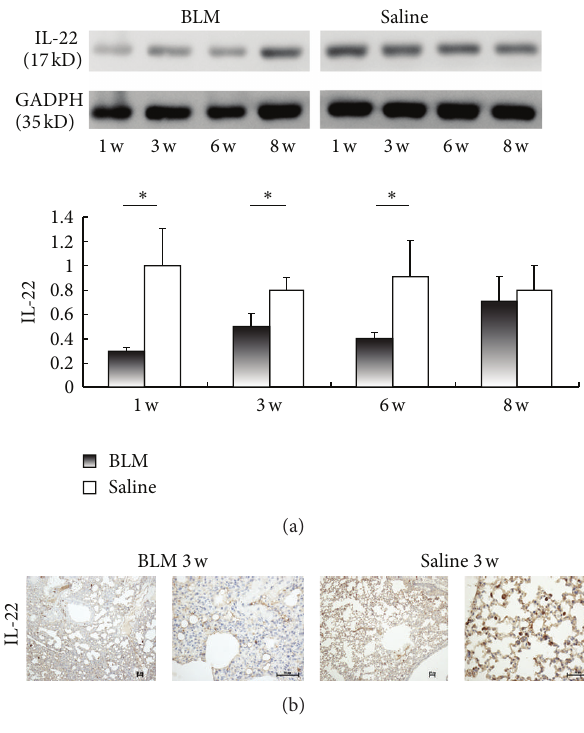
Figure 2: IL-22 is downregulated in lungs from bleomycin-treated mice. (a) Total protein level of IL-22 in lung homogenates was determined by western blotting and analyzed by densitometry compared to GADPH expression. The same amounts of total protein are loaded in each lane. Experiments were performed twice with similar results, with the same amounts of total protein loaded in each lane. (b) Representative photomicrographs of lung sections were obtained from mice treated with BLM or saline (week 3). IL- 22-positive cells were examined by immunohistochemistry. Bars = 50 𝜇 m. ∗ = 𝑃 < 0.05 ; ∗∗ = 𝑃 < 0.01 . Data presented in (a) are representative of results from two independent experiments with five mice in each group. Values are shown as mean ±